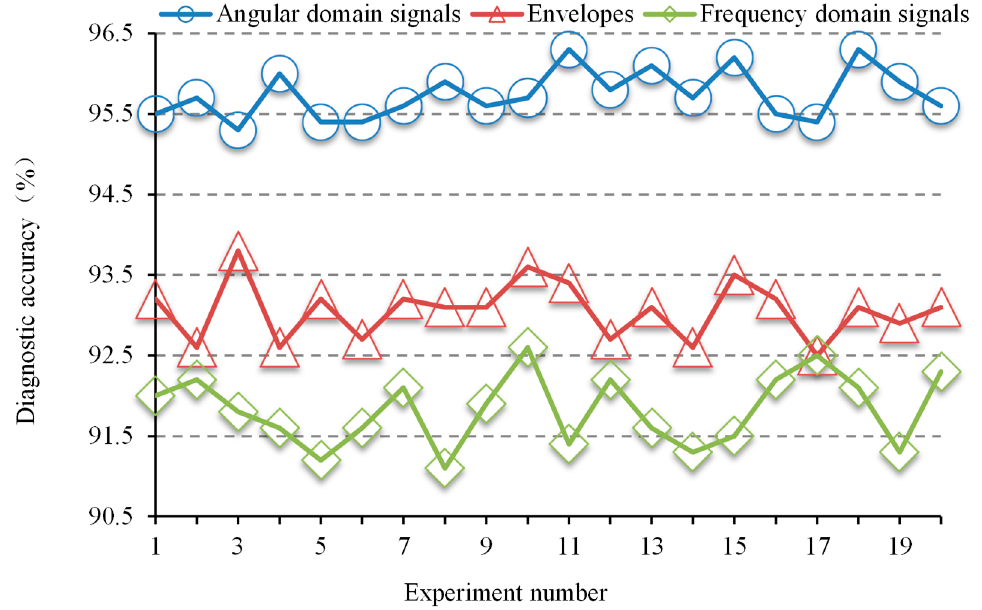
Figure 8. The diagnostic accuracy under three input modes.